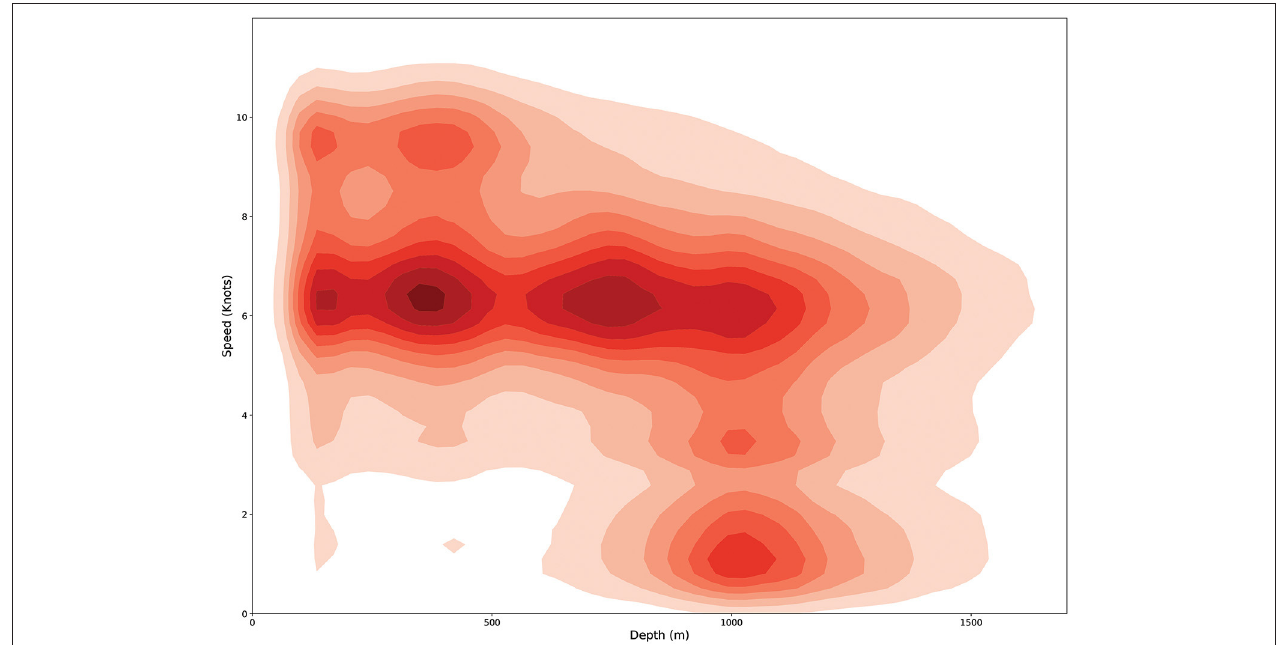
FIGURE 3 | Frequency distribution of the AIS messages broadcasted at different depths in the study areas (Blue tiles Gran Canaria and red tiles Tenerife). All the messages that were broadcasted from positions shallower than 100 m were filtered.